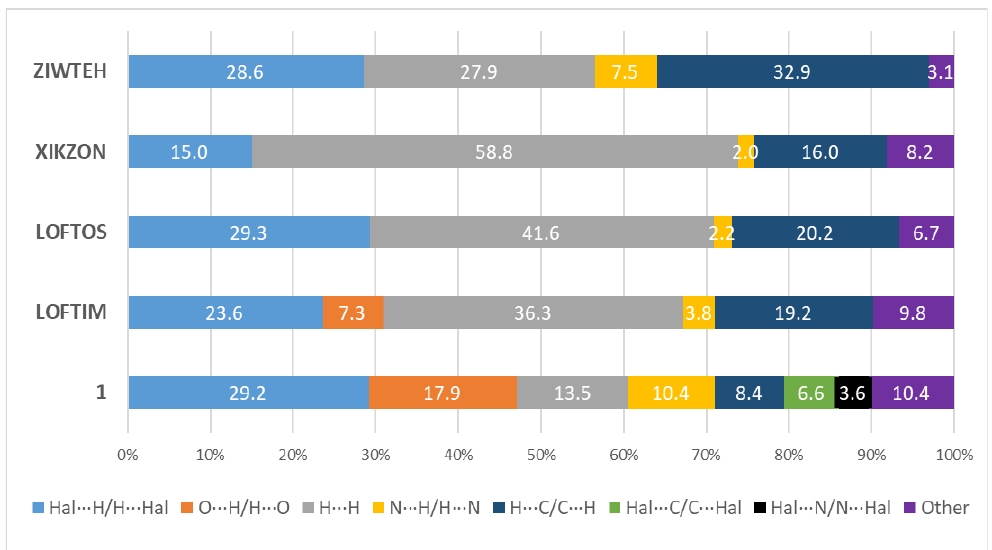
Figure 10. Percentage contributions of contacts to the Hirschfeld surface in structures 1 and taken from CSD. LOFTIM: bis(1H-benzimidazole)-(dibromo)-palladium(II) dimethyl sulfoxide solvate [53]; LOFTOS: bis(iodo)-bis(2-methyl-1H-benzimidazole)-palladium(II) [53]; XIKZON: Dichlorido[bis(2-hexylsulfanyl)-1H-benzimidazole- κ N 3 ]palladium(II) [54]; ZIWTEH: trans-Dichlorido-bis(1H-benzimidazole)-palladium(II)